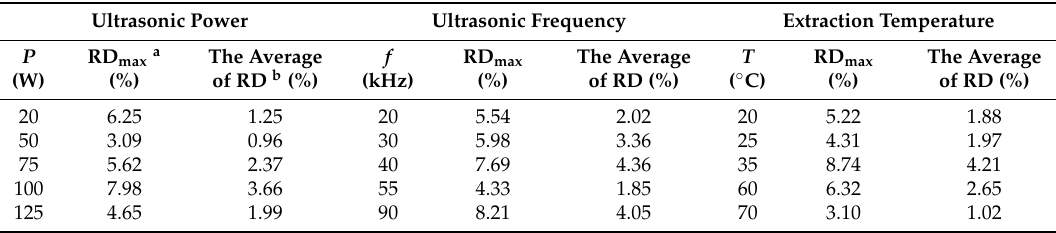
Table 4. The relative deviation between predictive values and experimental